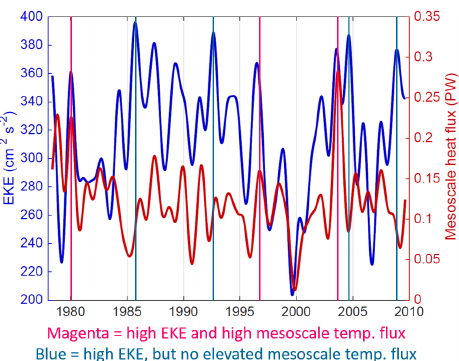
Figure 9. Comparison of the basin-integrated mesoscale tempera- ture flux (red) with the zonally averaged surface eddy kinetic energy (EKE; blue) along 40 ◦ N. The vertical lines indicate times of (ma- genta) high EKE and elevated MTF, vs. (blue) high EKE but without elevated MTF.